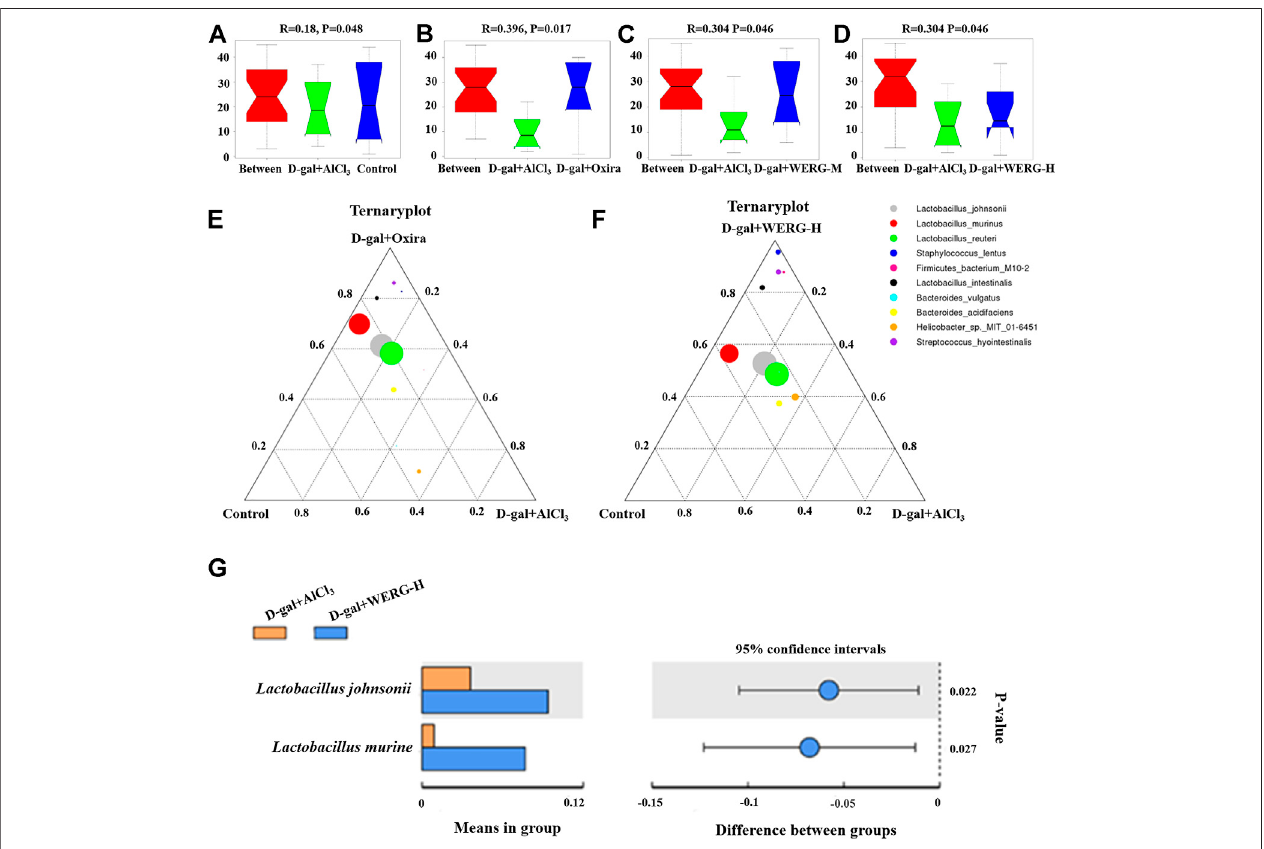
FIGURE 7 | WERG-H treatment increased the probiotic species. Anosim analysis results (A – D) ; ternary plot (E,F) ; t -test analysis (G) . Signi fi cant statistical difference by Student ’ s t-test ( p < 0.05). n = 5 mice per group.